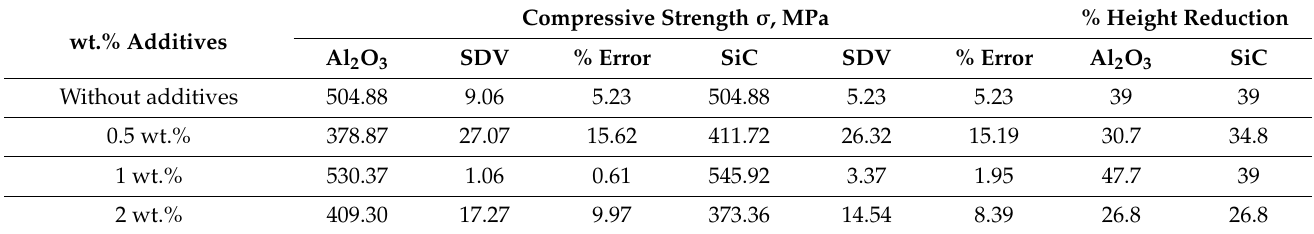
Figure 5. Average stress and strain relation for the Al-Si-Mg alloy filled with Al 2 O 3 in ( a ) graphite mold, ( b ) a steel mold. Table 1. Compression test results for the (Al 2 O 3 and SiC)/Al-Si-Mg composite casted in a graphite